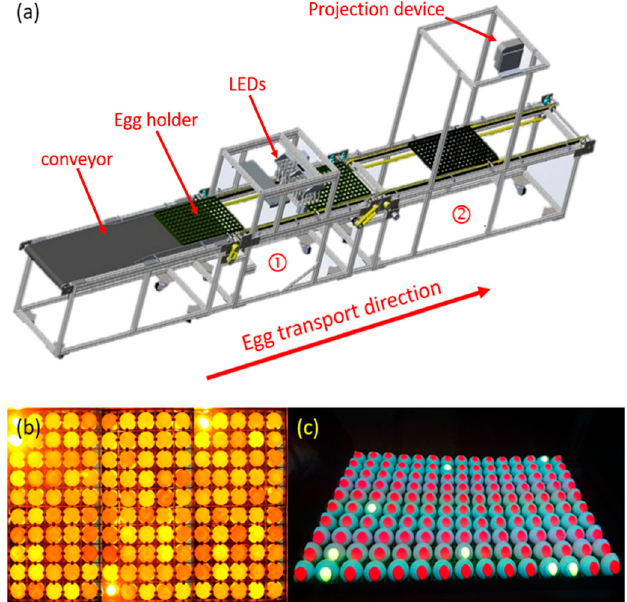
Figure 2. ( a ) Detection device (( 1 ) the image-capturing zone; and ( 2 ) the projection marking zone); ( b ) schematic of image capturing; and ( c ) schematic of projection marking.